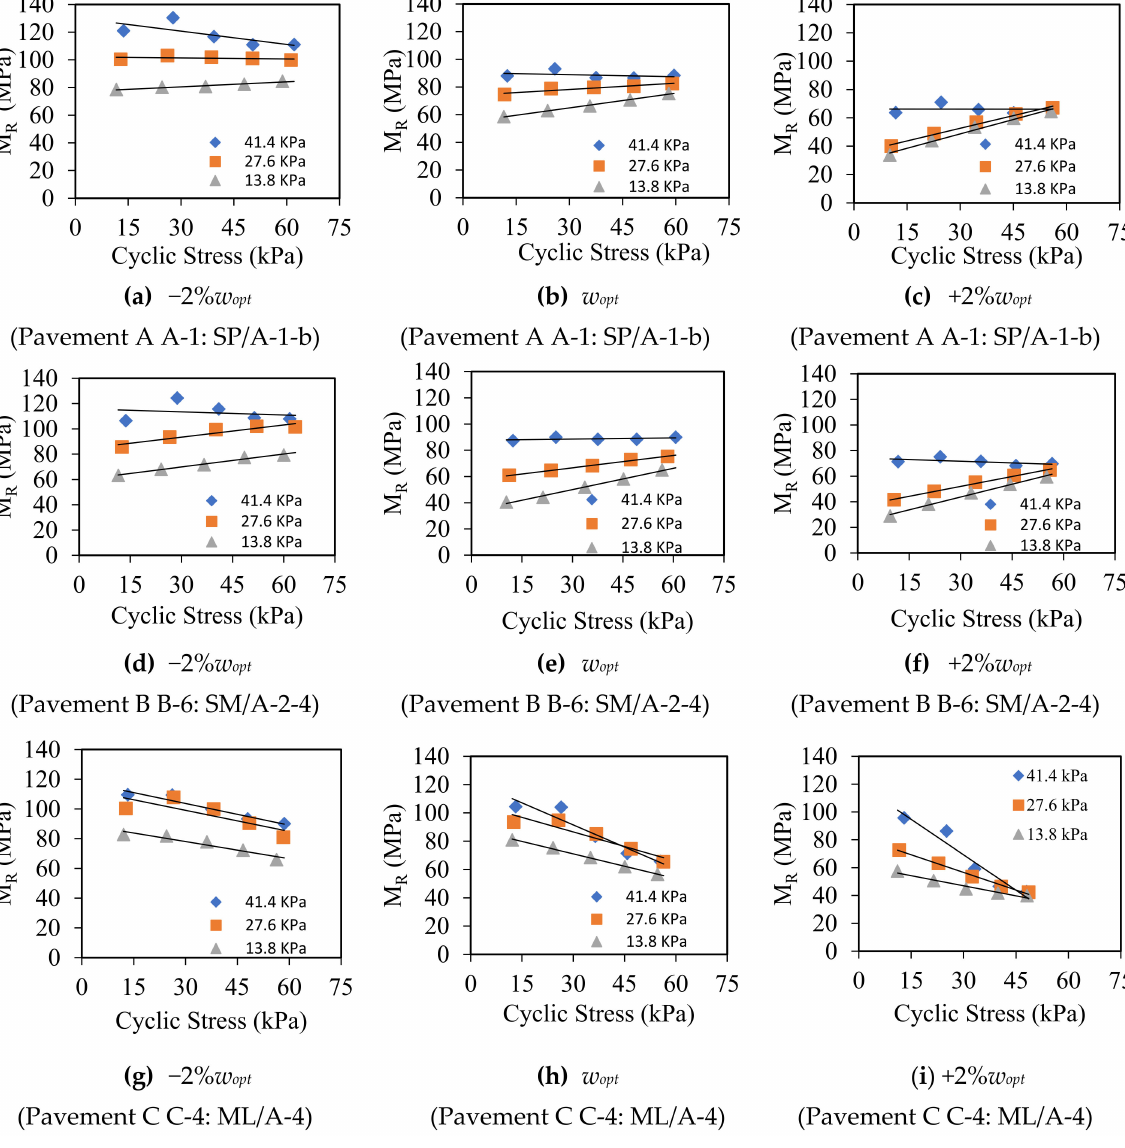
Figure 3. Resilient Modulus Test